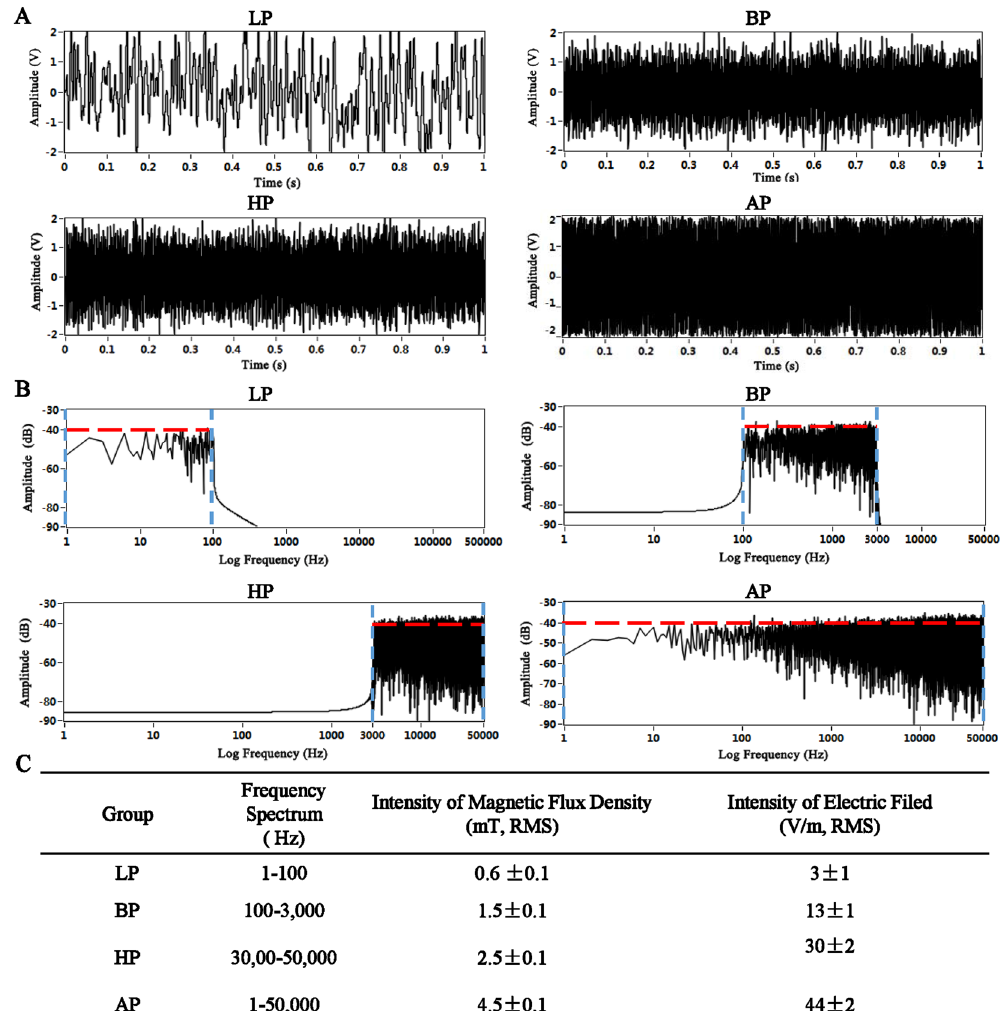
Figure 2. Illustration of four kinds of EMF waveform signals in time and frequency domain and the measurement results of magnetic flux density and electric field strength of four kinds of EMF. ( A ) Four kinds of EMF waveform signals in time domain. ( B ) Four kinds of EMF waveform signals in time domain. ( C ) Measurement results of magnetic flux density and electric field strength of four kinds of EMF by using a Gaussmeter and an electric field